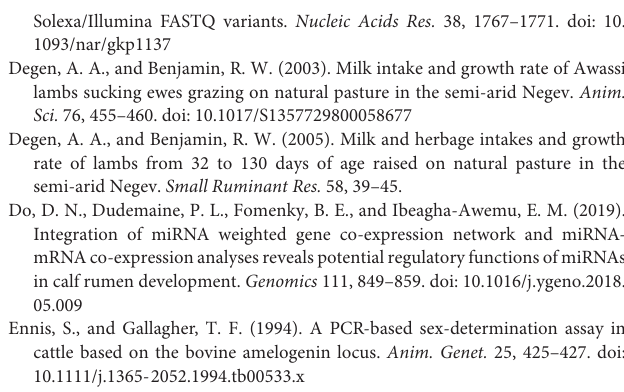
Supplementary Figure 1 | Sequence alignment of goat circRNA and human circRNA. Supplementary Figure 2 | Pathway analysis of the parental genes of differentially expressed circRNAs (DECs). (A) The top 20 pathways of the parental genes of the stage-specific DECs in F135. (B) The top 20 pathways of the parental genes of the stage-specific DECs in